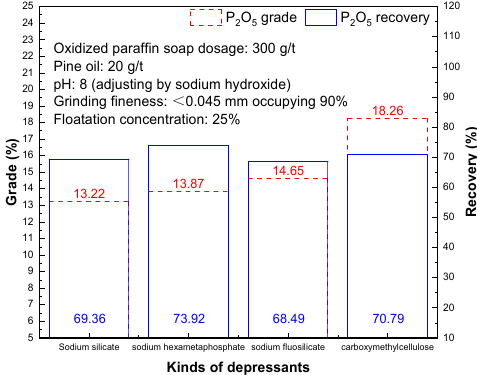
Figure 4. E ff ect of di ff erent depressants on extracting Figure 4. Effect of different depressants on extracting phosphorous.